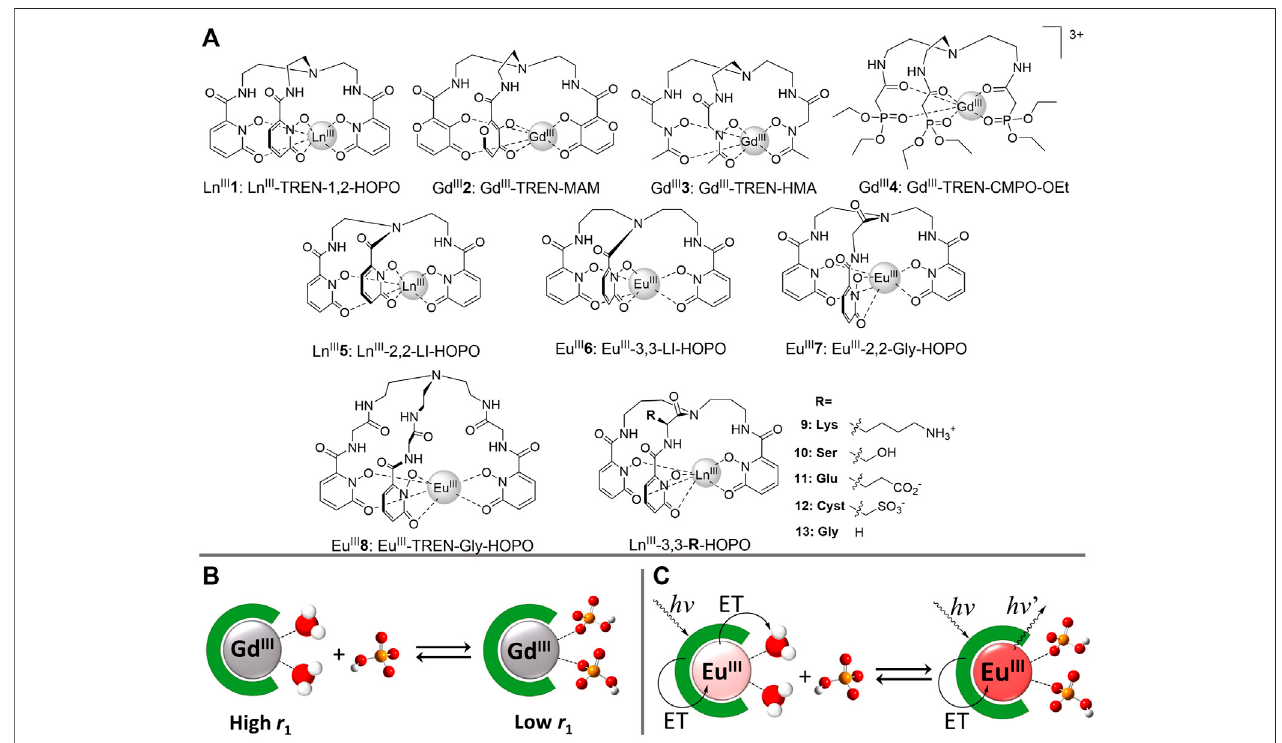
FIGURE 1 | (A) Chemical structures of phosphate receptors (B) Relaxivity response of Gd III receptors to phosphate binding. Rapidly exchanging water molecules bound to Gd III enhance the proton relaxation of the bulk water, resulting in high longitudinal relaxivity ( r 1 ). Bound phosphate anions prevent coordination of water molecules, thereby reducing the proton relaxation of the bulk solvent and decreasing the relaxivity ( r 1 ) (C) Luminescence response of Eu III receptors to phosphate binding. Coordinated water molecules ef fi ciently quench Eu III luminescence. Phosphate anions displace the inner-sphere water molecules upon coordination, which increases the Eu III -centered luminescence intensity and